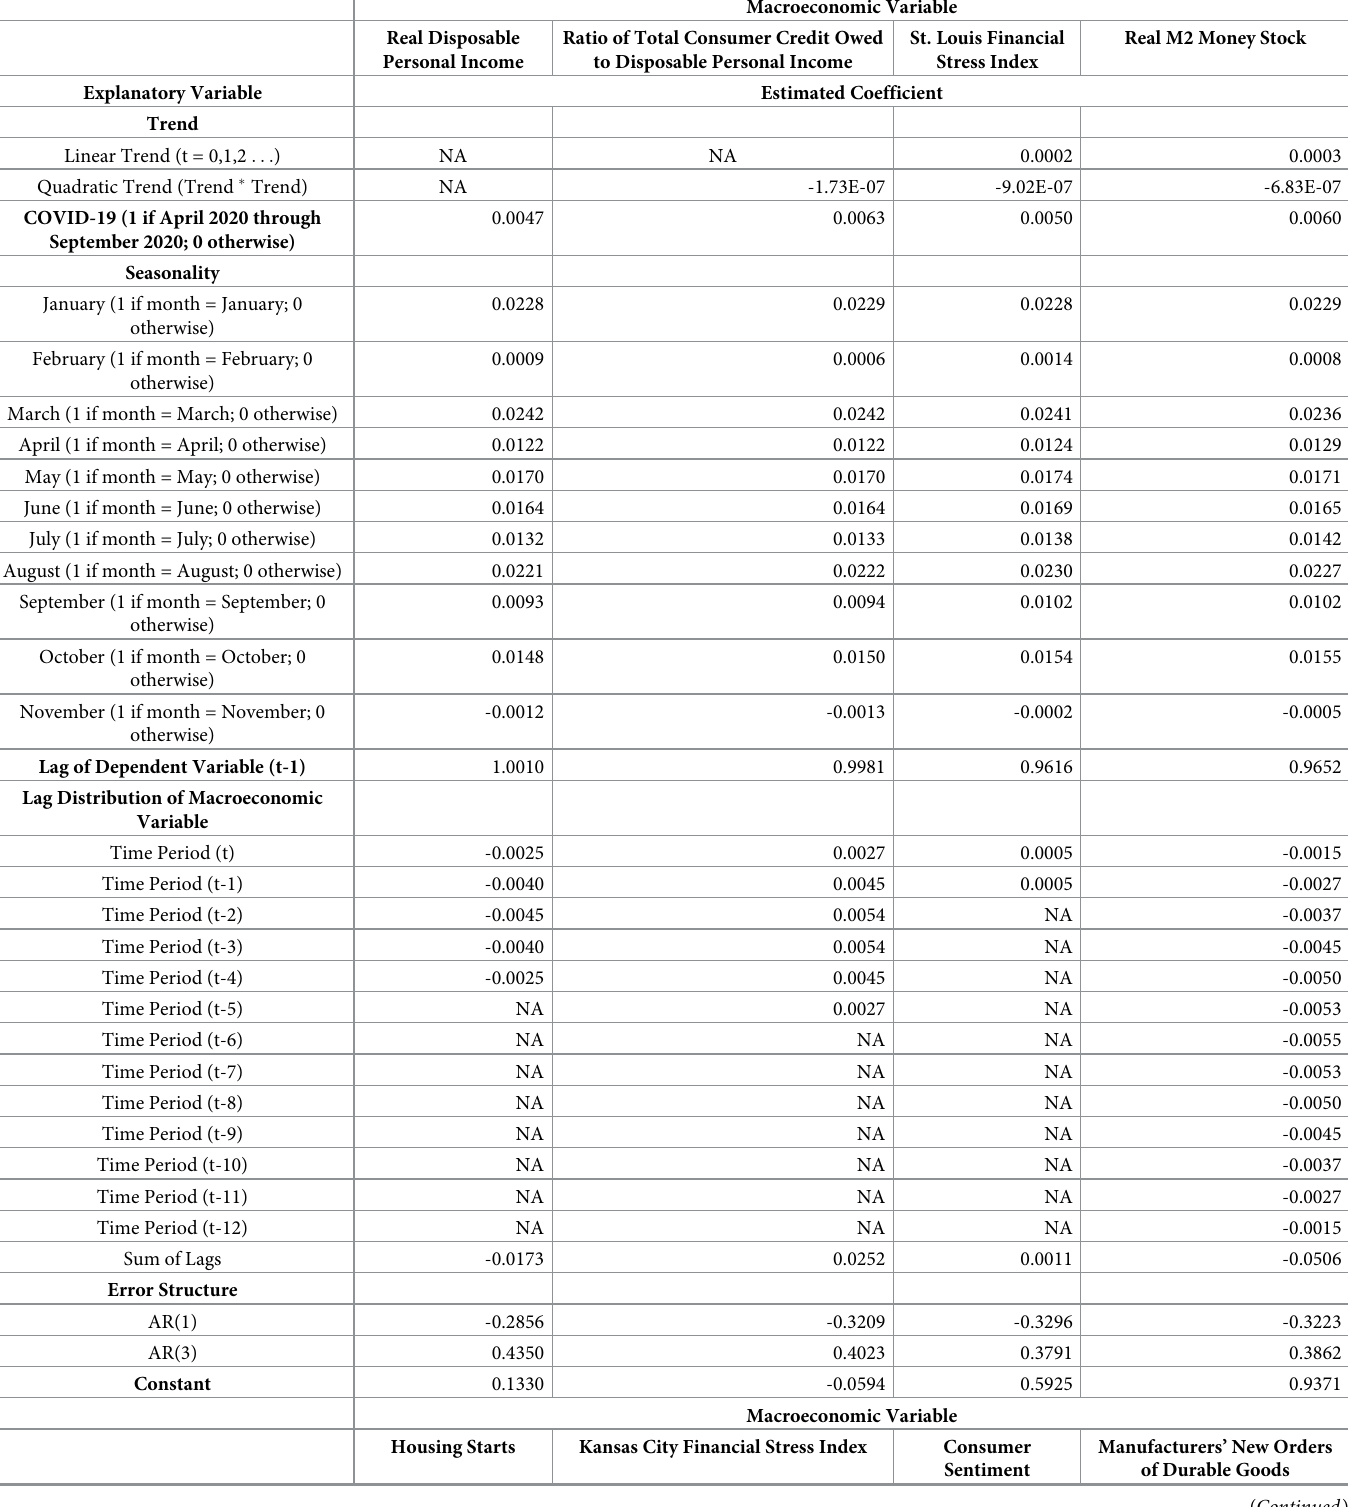
Table 4. Estimated econometric models associated with WIC participation, October 1999 to September